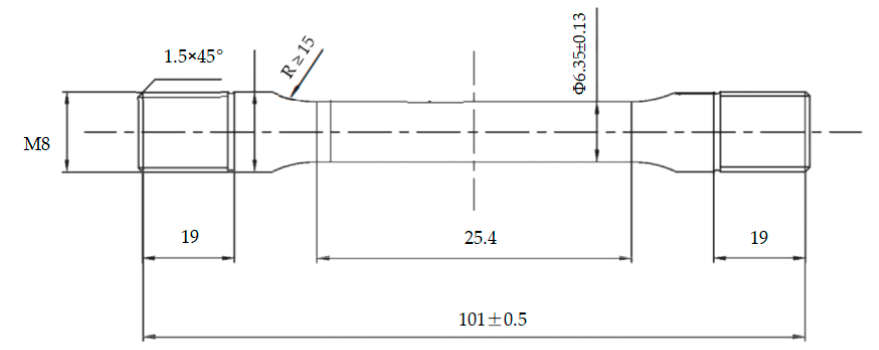
Figure 3. Geometry and dimensions of SSC test method-A tensile specimen .